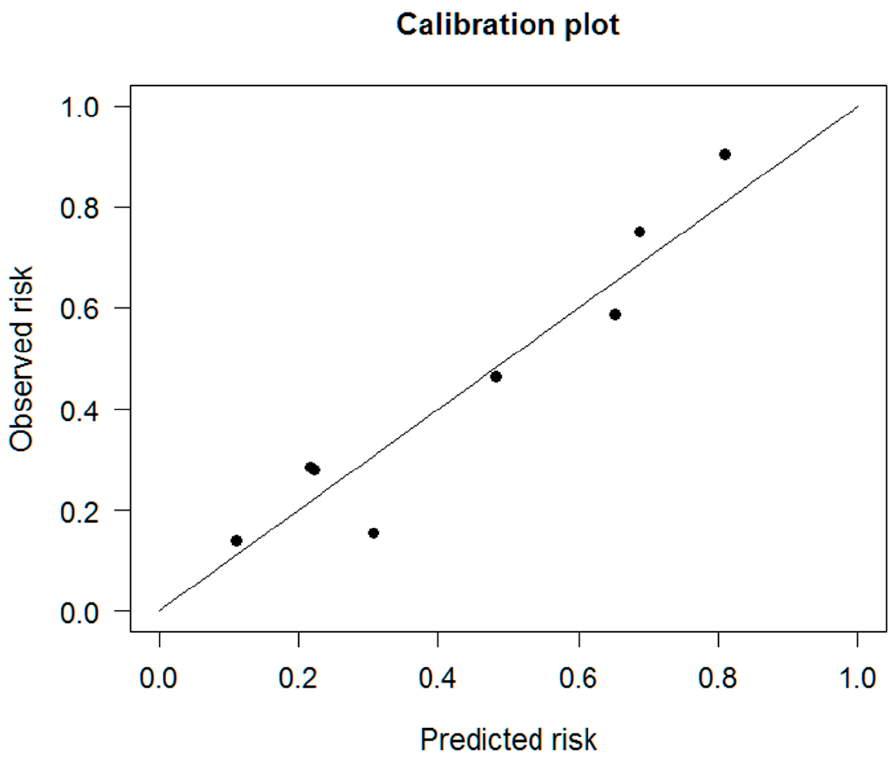
Figure 5. Calibration plot for the Hosmer–Lemeshow goodness of fit test for the risk prediction model.